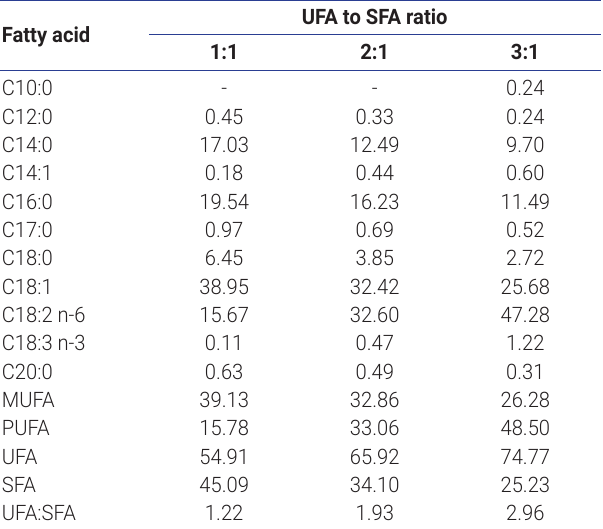
Table 2. Fatty acid composition of the experimental diets (% total fatty